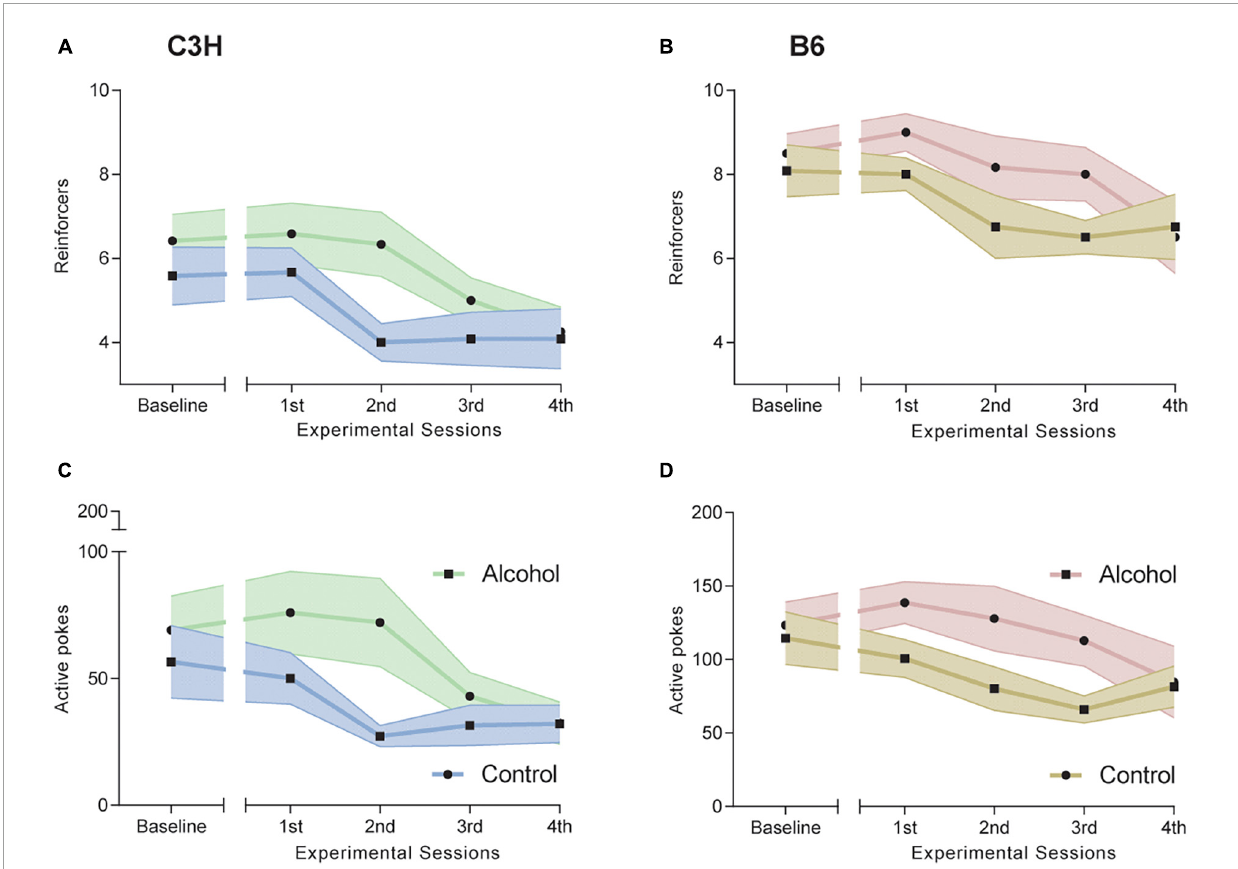
FIGURE3 Effects of alcohol exposure and subsequent withdrawal in alcohol oral self-administration (OSA). Number of reinforcers taken (A,B) and of active nose pokes (C,D) during the five progressive ratio (PR) experimental sessions for C3H (A,C) and B6 (B,D) mice. Data are shown as group means, with the shaded area representing ± SEMs. n = 12 per group/strain.